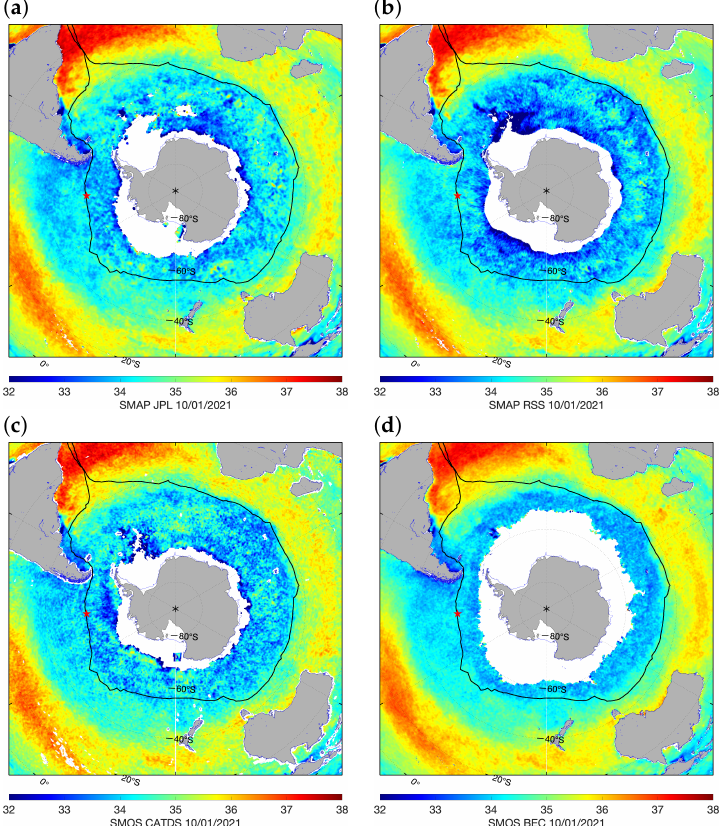
Figure 9. Example of SSS remotely sensed products for the 10 January 2021. ( a ) SMAP JPL; ( b ) SMAP RSS; ( c ) SMOS CATDS and; ( d ) SMOS BEC. The black line indicates the trajectory of One Ocean One Planet ship and the red star its position on 10 January